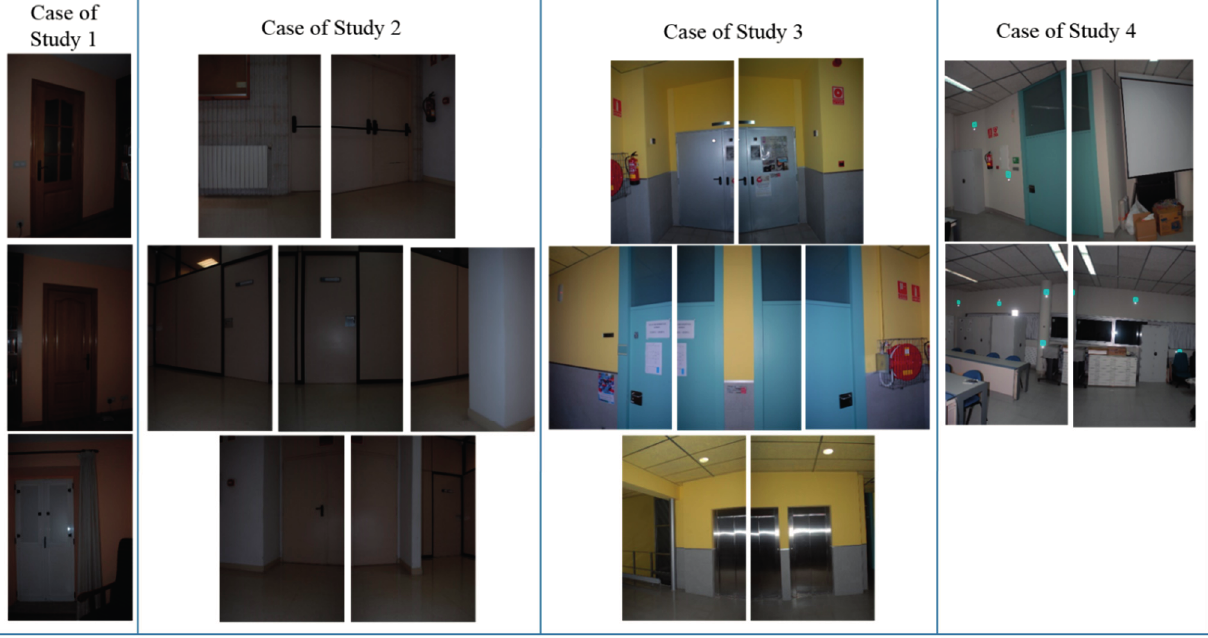
Figure 3. The first three cases of study present different kinds of closed doors. The